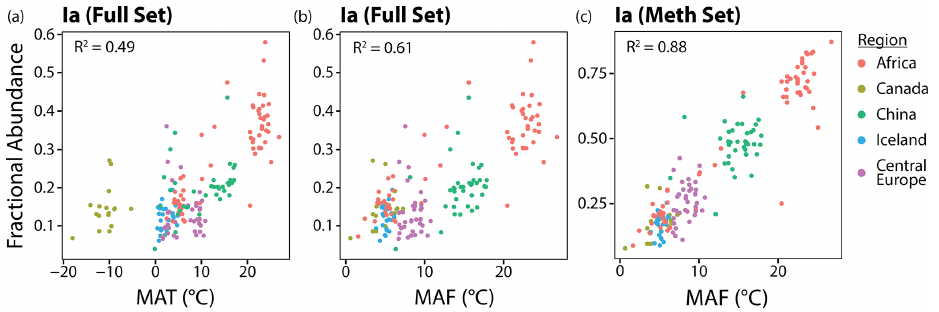
Figure 5. From left to right, the effects of substituting the months above freezing (MAF) warm-season index for mean annual temperature (MAT) and fIa Meth for fIa Full on the relationship between the fractional abundance of brGDGT-Ia and temperature.